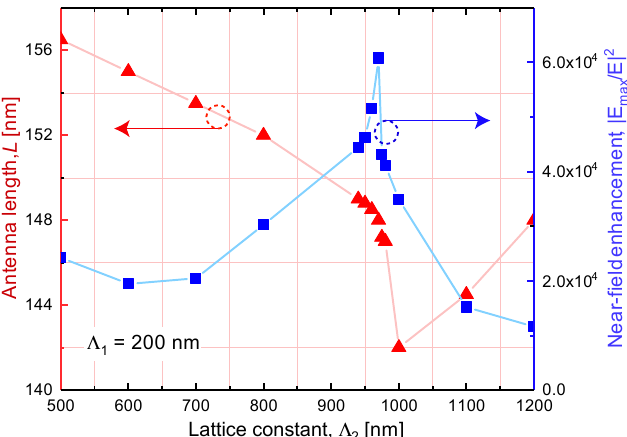
Figure 7. Variation of the local field enhancement (blue curve) and the resonant nanoantenna length L (red curve) with the lattice period Λ 2 when the other lattice period is fixed at Λ 1 = 200 nm and ensuring constant collective Localized surface plasmon resonance (LSPR) band at λ = 1494 nm. The analyte film thickness t = 35